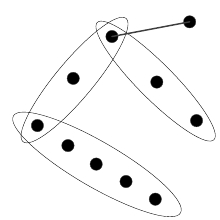
Figure 2. An example hypertree.